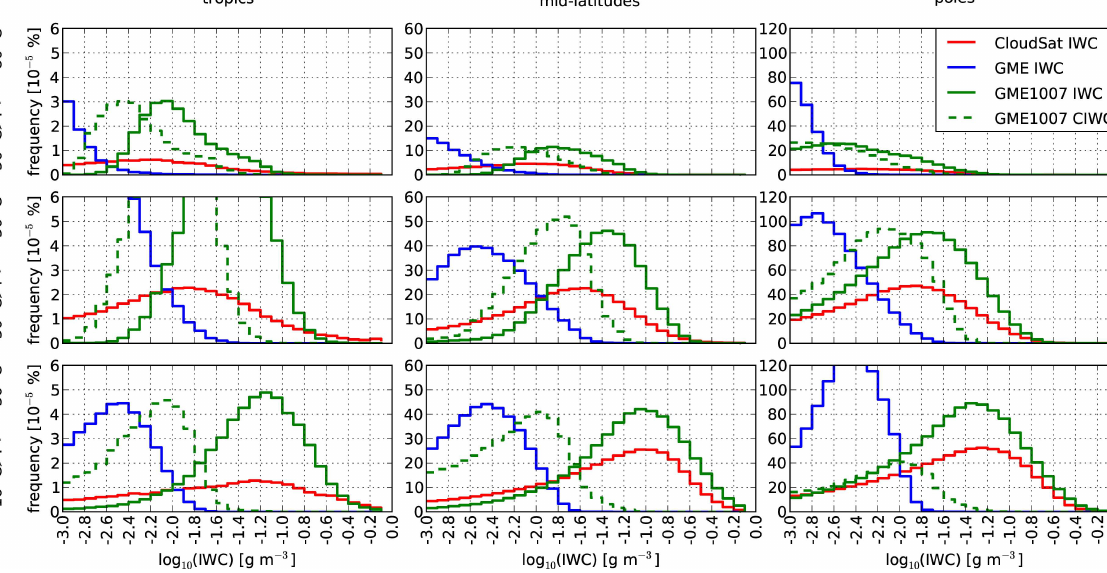
Geosci. Model Dev., 4, 579–589,